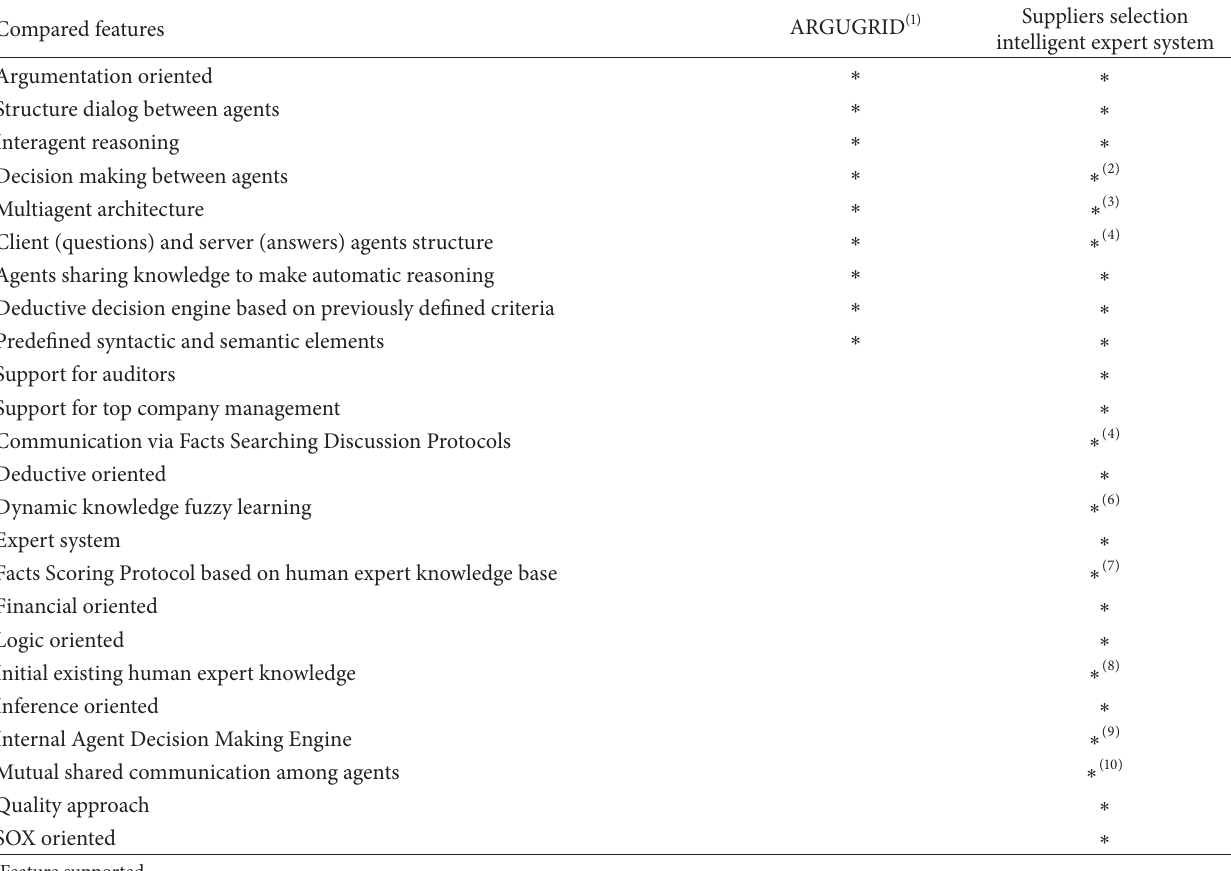
Table 17: Comparison of proposed model versus